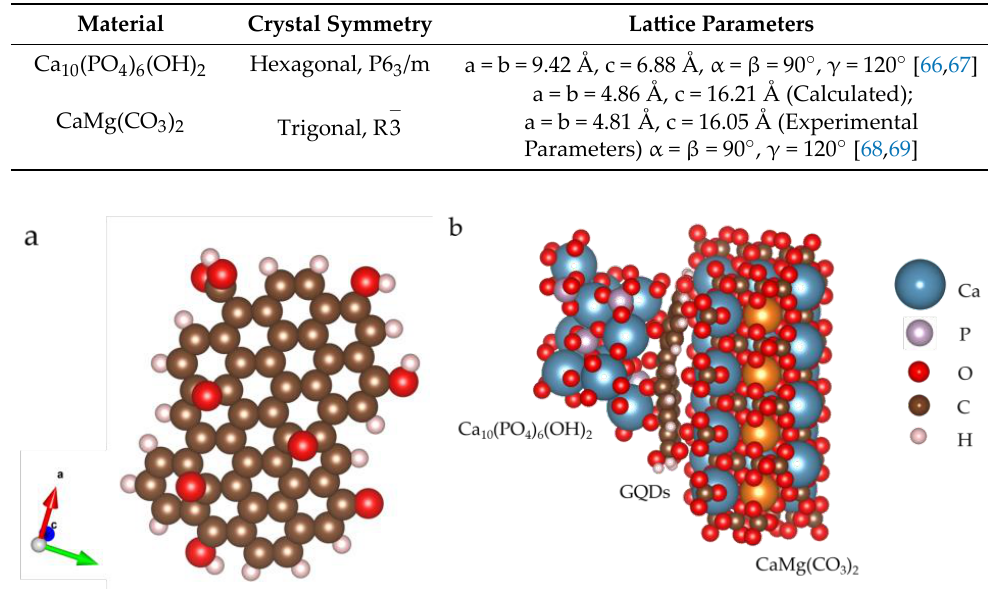
Figure 8. Geometrical configurations and molecule models of involved materials: ( a ) GQD molecule configuration; ( b ) The suppositional combination model among Ca 10 (PO 4 ) 6 (OH) 2 , GQDs and CaMg(CO 3 ) 2 .